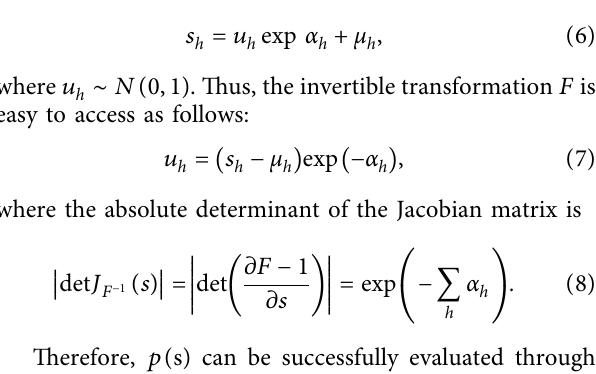
to t . (b) Grid 1 3